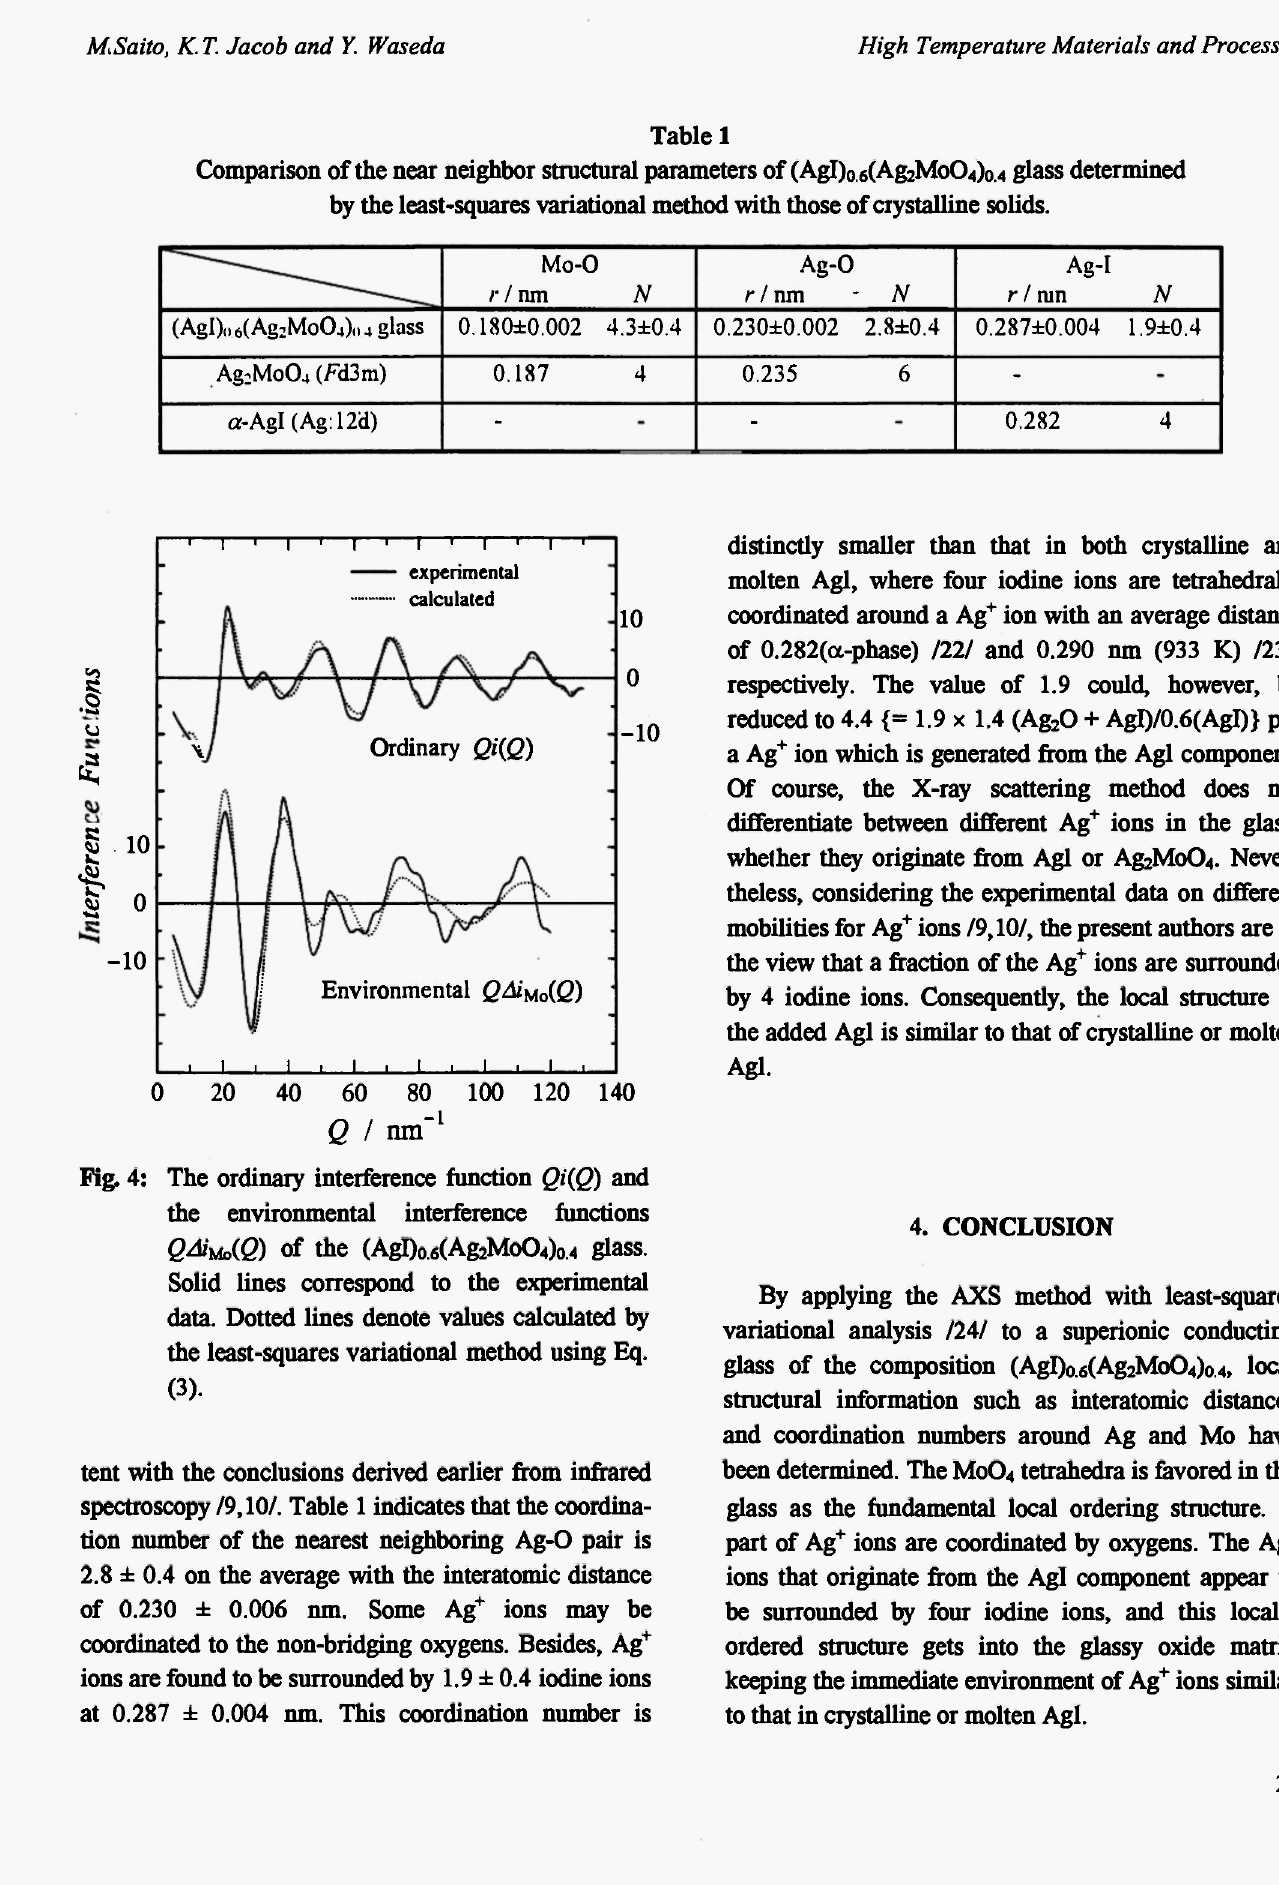
Comparison of the near neighbor structural parameters of (AgI)o.6(Ag2Mo0 by the least-squares variational method with those of crystalline solids.